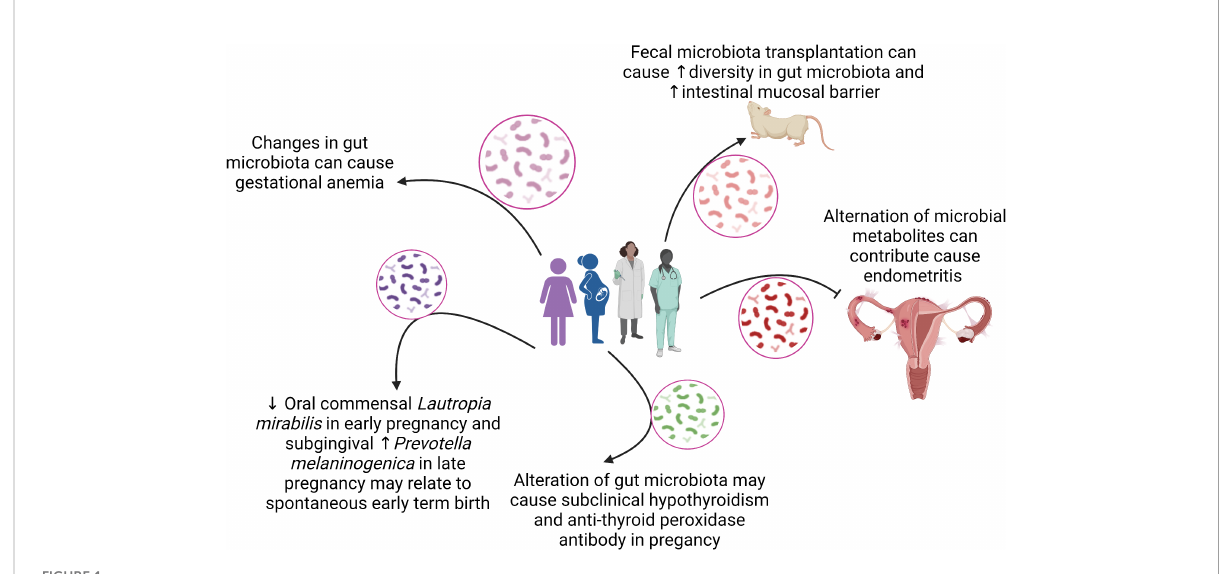
FIGURE 1 The association between microbiomes and women